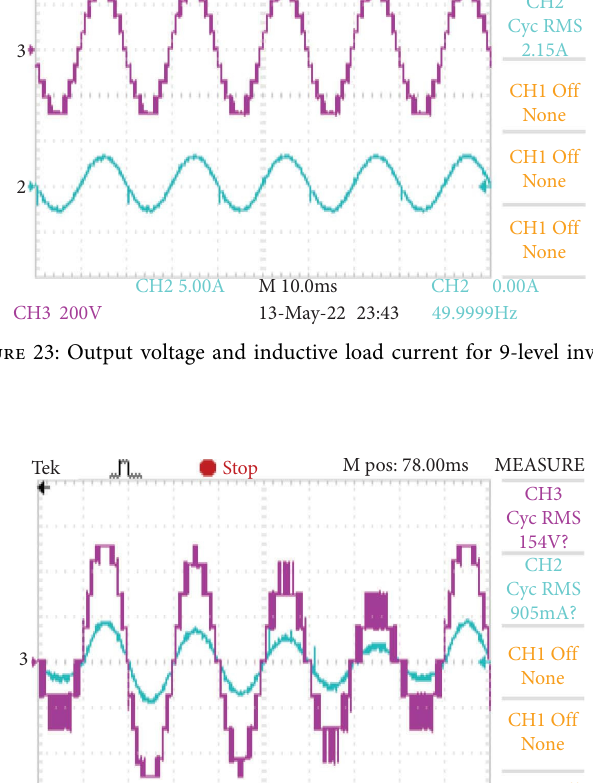
a under constant load condition.